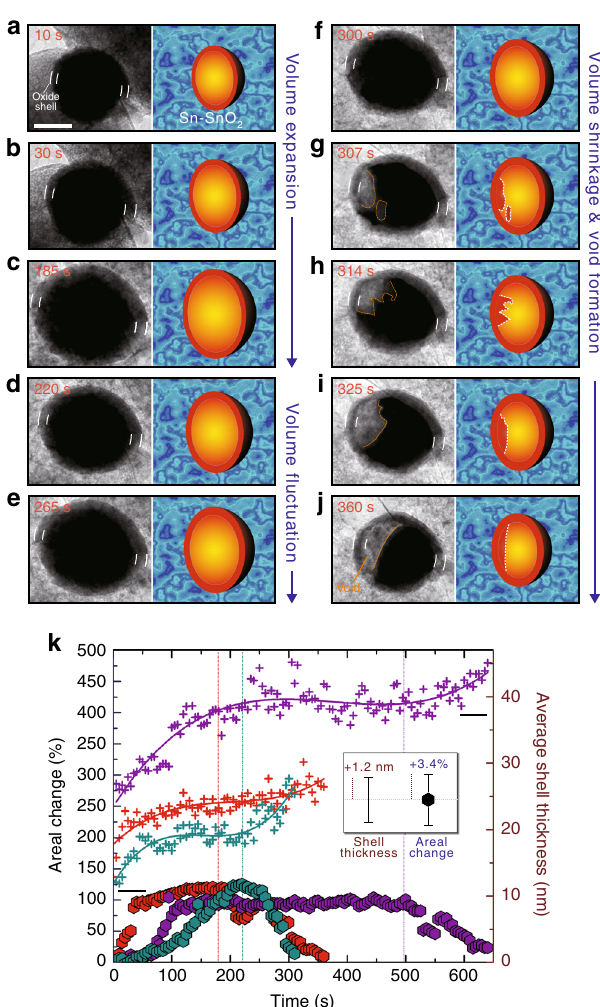
Fig. 2 Void-forming morphological evolution during lithiation under stress. a – j Time-series transmission electron microscopy (TEM) images from Supplementary Movie 3 showing dimensional and morphological evolutions of a Sn-SnO 2 nanoparticle during in situ lithiation for 360 s. White borderlines on each panel note the oxide shell edges. Orange curves highlight the fl uctuating void surface on the Sn core. The illustrations next to the TEM images describe the morphological evolution of the particles, including swelling, shrinking, and void formation/evolution. The scale bar indicates 100 nm. k The areal changes (hexagons) and average oxide shell thicknesses (cross-shapes) plotted over the lithiation time, for three similar Sn-SnO 2 particles under two different electron-beam conditions. The error bar indicates the standard deviations obtained from 10 image frames separated by 0.5